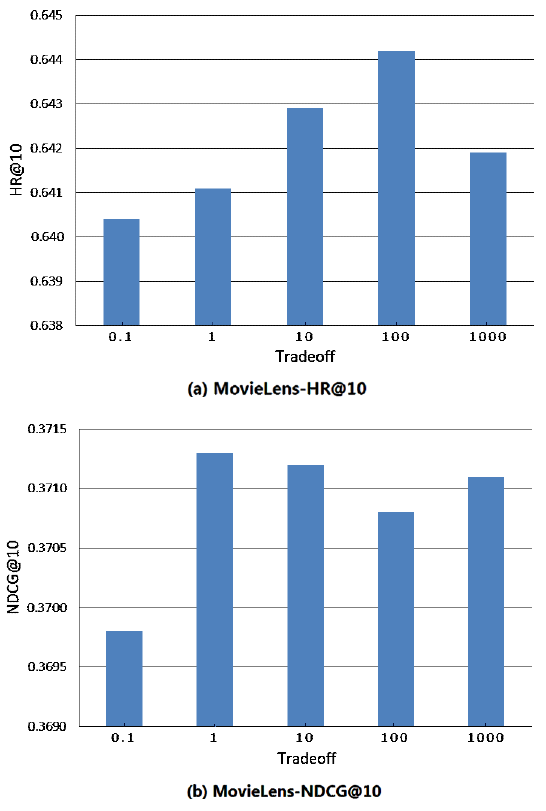
Fig. 7 Trade-off effect on HR@10 and NDCG@10.